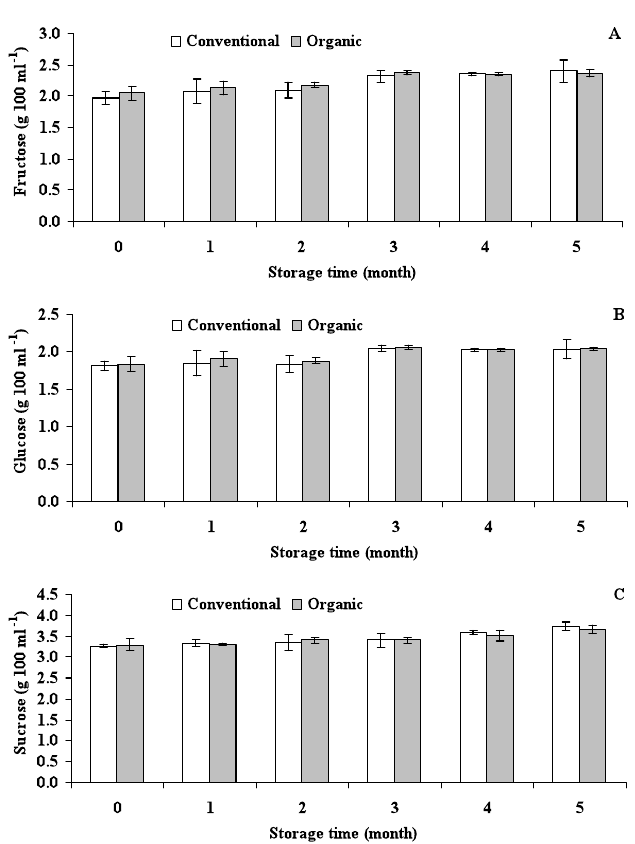
Fig. 4: Changes in sugar/acid ratios (TSS/TA) and taste scores of conven- tionally and organically grown ‘Washington Navel’ oranges during storage at 4°C.